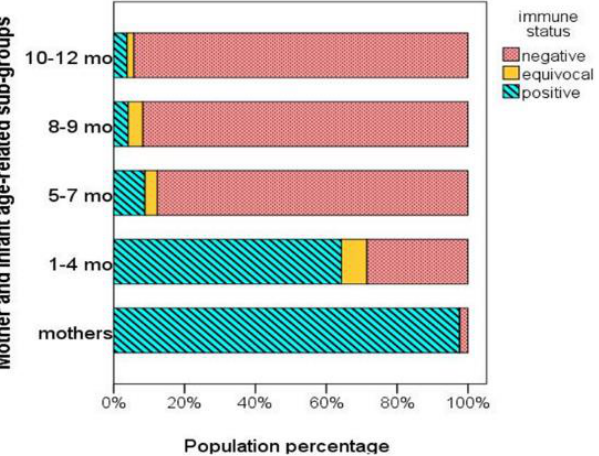
Figure 2. Percentages of mothers and infants of different age-related subgroups with protective (positive), equivocal, and non-protective (negative) measles antibody levels.